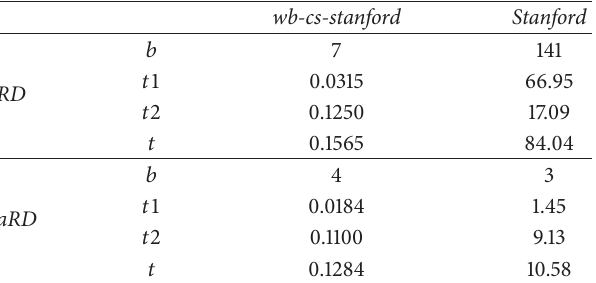
Table 1: Comparison of RD and aRD